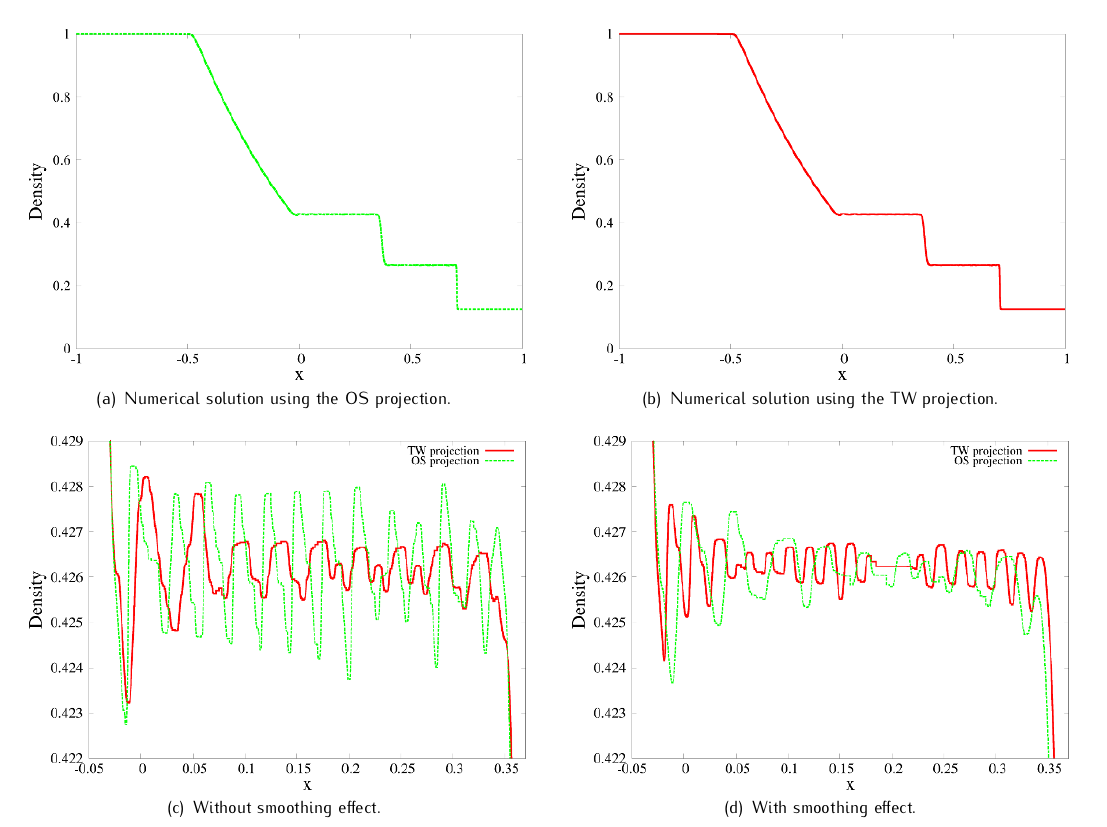
Figure 5. Sod’s shock tube problem: numerical oscillations with/without smoothing effect at time t = 0 . 4 with L the Osher–Sanders projections are used.